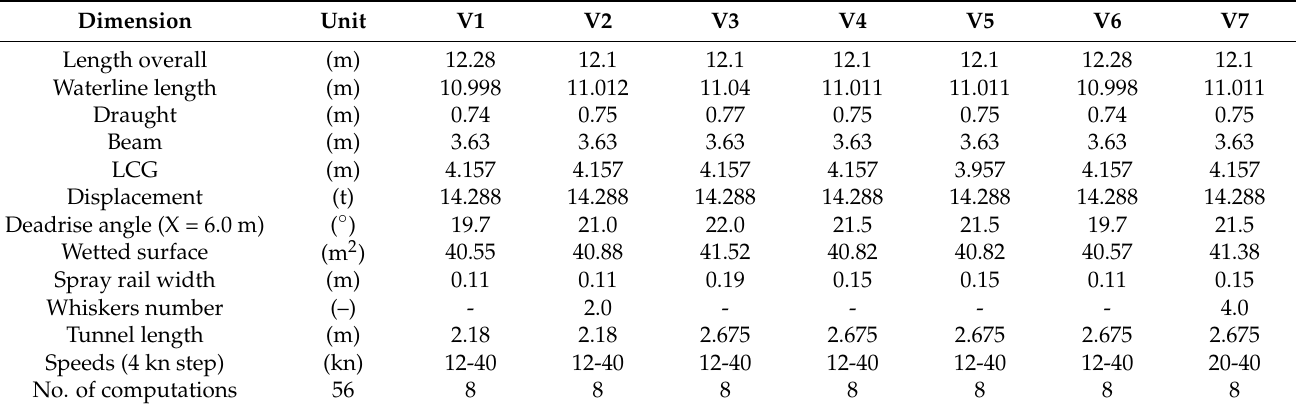
Table 2. Test cases and hull characteristics.